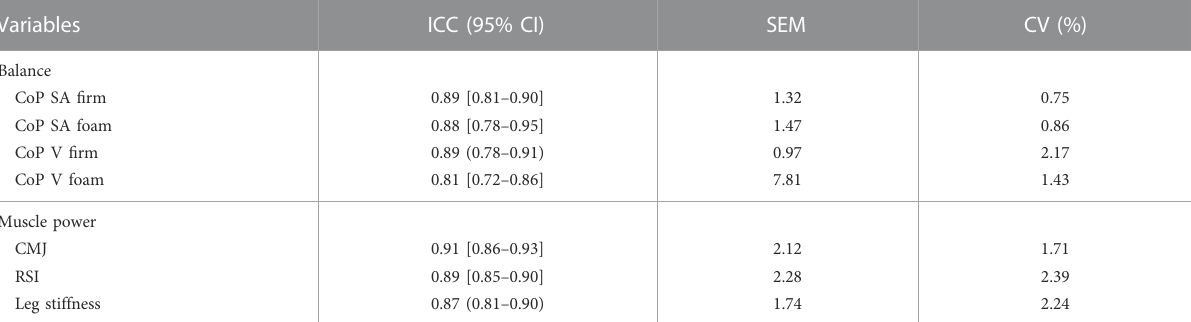
TABLE 2 Test-retest reliability of the applied balance and strength/power tests.